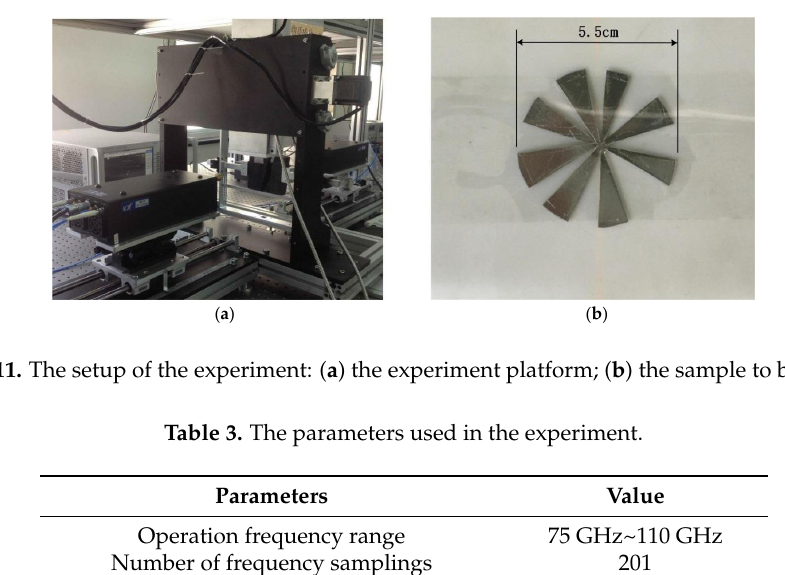
( b ) Figure 10. PMA applied to electromagnetic field simulation in the multistatic antenna array case: ( a ) the slice figure; ( b ) 3-D reflectivity figure.